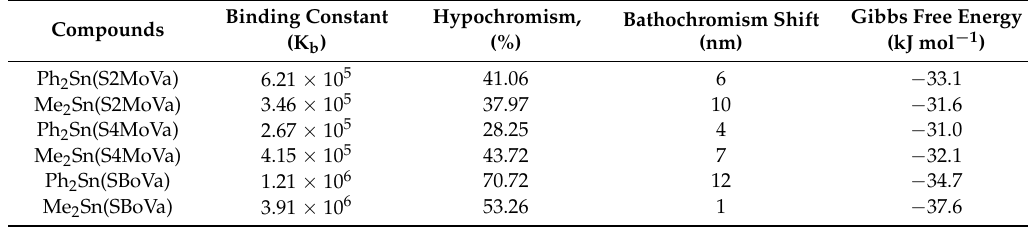
Table 3. Binding constants (K b ), hypochromism (%), bathochromic shifts (nm) and Gibbs free energy (kJ mol − 1 ) values for the interaction of organotin(IV) compounds with calf thymus DNA (CT-DNA). Binding Compounds